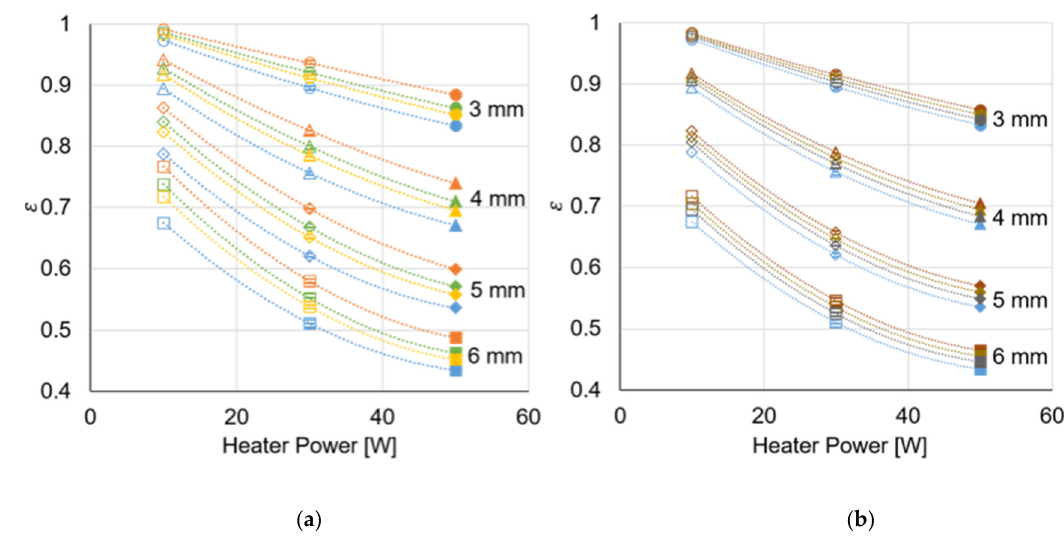
Figure 6. Effectiveness at different pipe diameters for ( a ) MTP and ( b ) PTP. Figure 6. E ff ectiveness at di ff erent pipe diameters for ( a ) MTP and ( b )